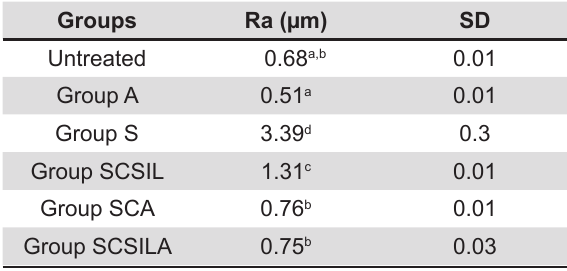
Figure 3- Fourier Transform Infrared spectrometer (FTIR) spectra of the untreated polymethylmethacrylate (PMMA) and the experimental